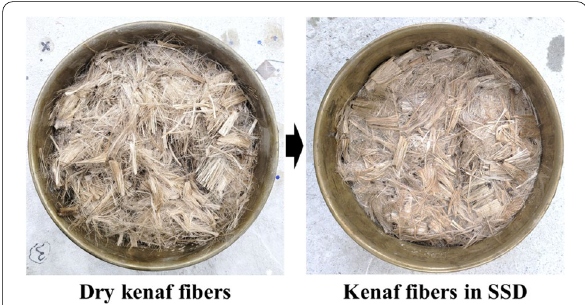
Fig. 3 Kenaf fiber sample before and after being prepared in SSD